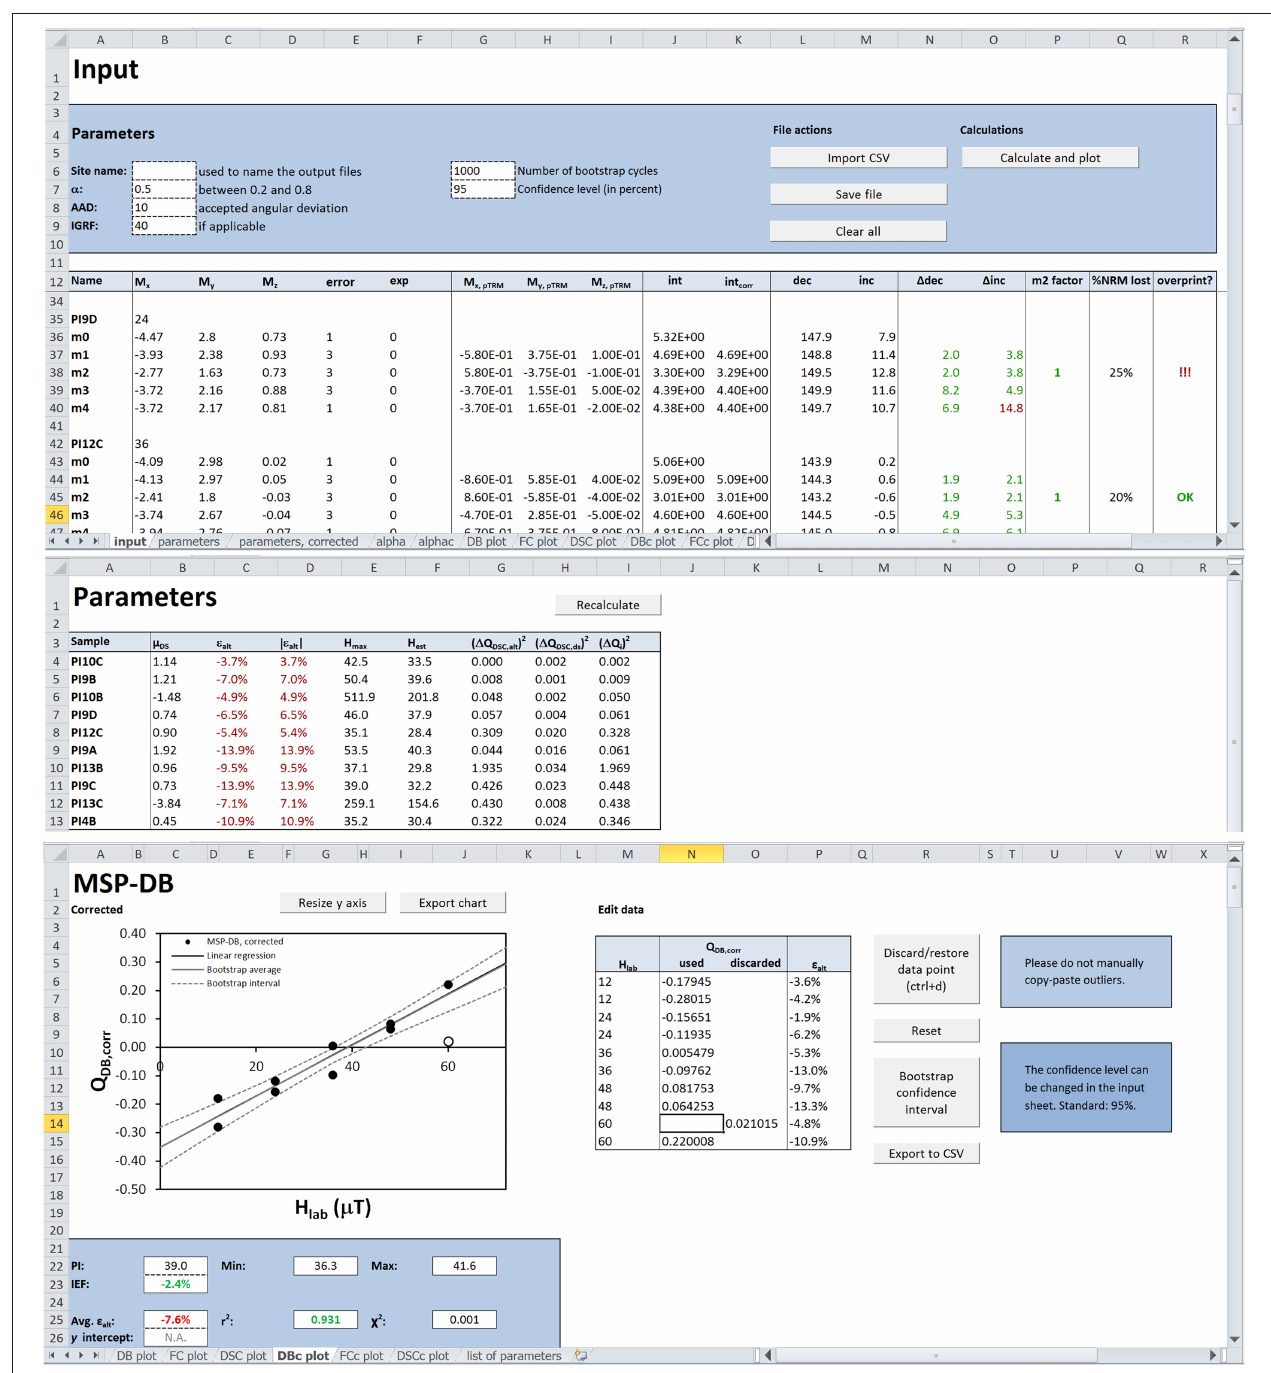
FIGURE 1 | User interface, from top to bottom: the “input” sheet, the “parameters” sheet and one of the “plot” sheets (MSP-DB).